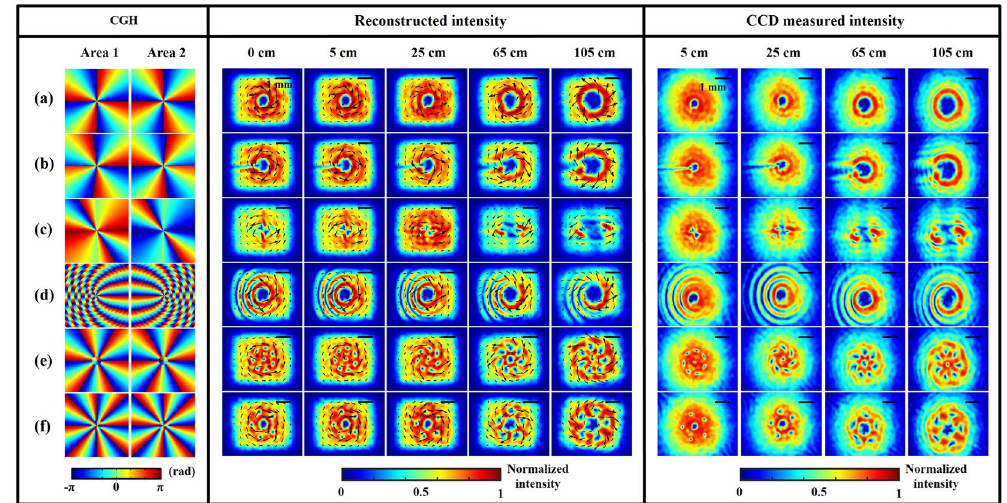
Figure 2. Holograms used to generate complex beams and the corresponding diffraction results along the beam propagation direction. The first block shows the designed CGHs that contain no blazed structure. As explained in the supplementary information, two displayed CGHs in each case are opposite in sign. The second block shows the DH reconstructed results of generated fields from the source plane at z = 0 to other planes at z = 5, 25, 65, 105 cm. The third block shows the intensity patterns captured directly by a CCD camera. ( a ) Case with q = 2, ( b ) case with fraction q = − 1.8, ( c ) case with q = − 1 in first and third quadrants and q = 3 in second and fourth quadrants, ( d ) case with radially variant q changing from 2 at the center to 8.5 at the border with an interval of 0.5 every 15 pixels, ( e ) case with q = − 0.5 for the inner region r ≤ 67 pixels and q = 3 otherwise, ( f ) case obtained by extracting the phase profile from the superposition of LG 0, − 3 and LG 0, − 8 modes. The arrows in the DH results represent the direction of the OFD. The scale bar in the right-top corner in each figure is about 1 mm. The intensity distribution of each figure is normalized to unity.